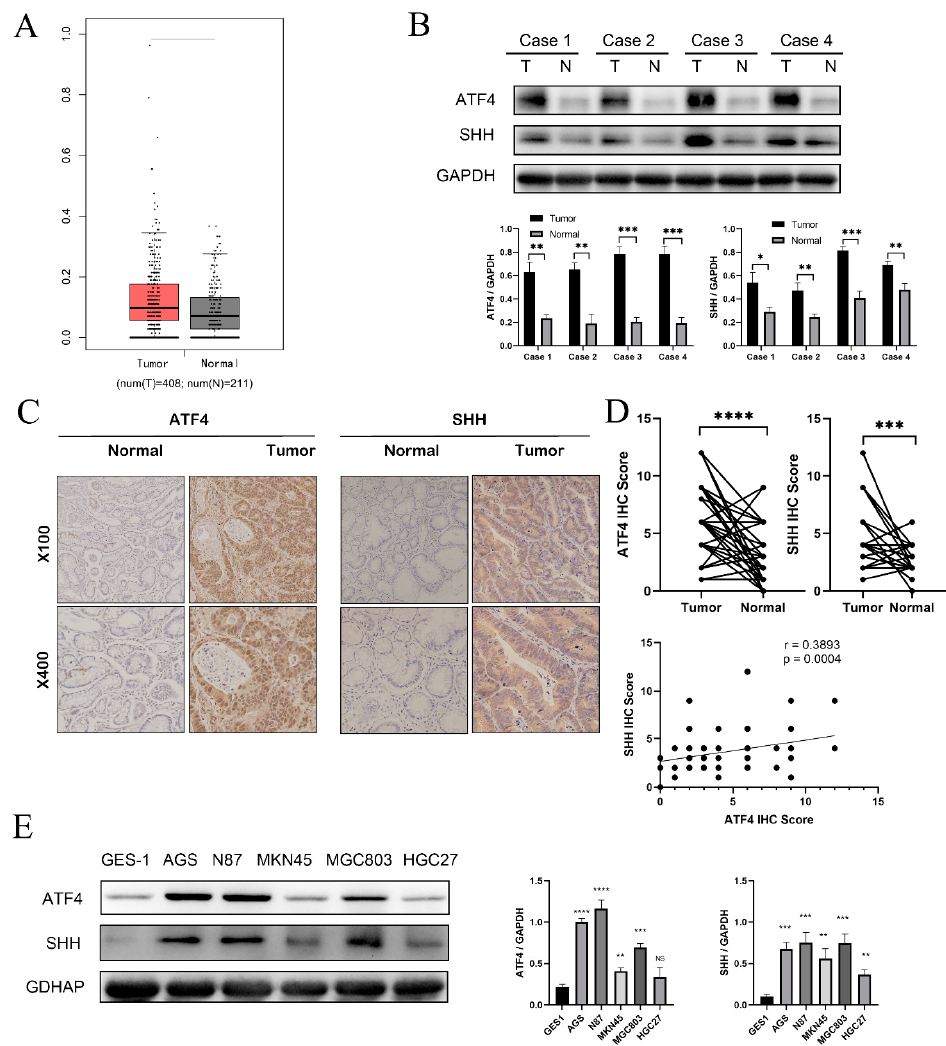
Figure 1. ATF4 is highly expressed in gastric cancer tissues and gastric cancer cell lines. ( A ) The expression of ATF4 is higher in gastric cancer ( n = 408) than in normal samples ( n = 211) in the GEPIA database. ( B ) Western blot analysis results of ATF4 in four pairs of gastric and adjacent gastric tissue. ( C ) Immunohistochemical analysis of ATF4 and SHH expression in a GC patient tissue array ( n = 80). Representative images are shown. ( D ) Paired t-test showing results of immunohistochemistry. ( E ) Western blot shows the expression of ATF4 in human gastric mucosal epithelial cells (GES-1) and gastric cancer cell lines. * p < 0.05, ** p < 0.01, *** p < 0.001, and **** p < 0.0001. NS means statistically insignificant. The original western blot figures could be found in Supplementary S2.